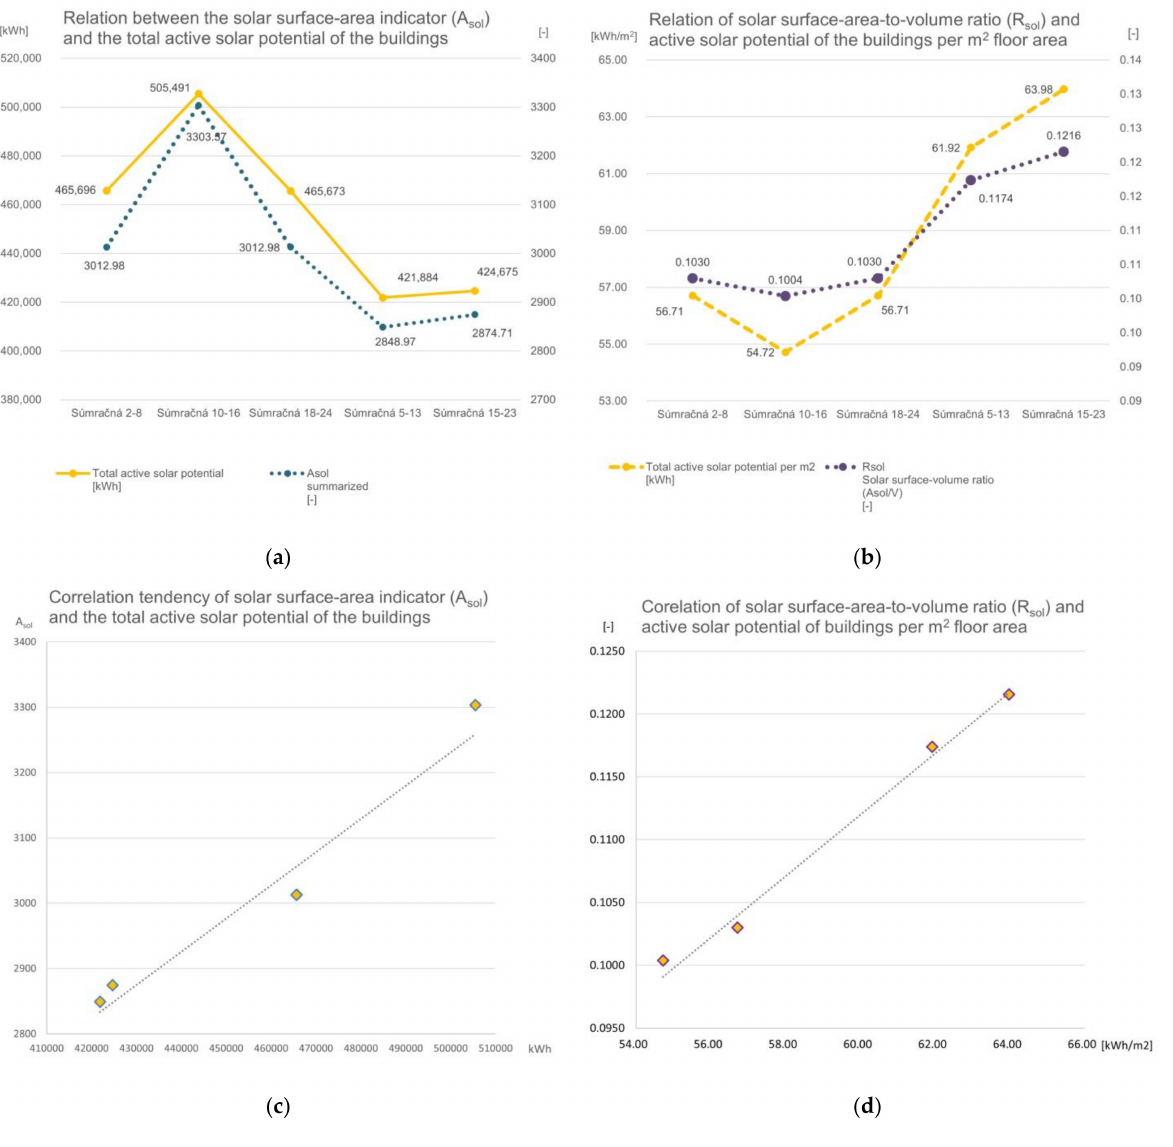
Figure 14. Four graphs visualising the calculation results shown in Table 6 and focusing on the relation between particular energy performance values and proposed indicators: ( a ) Confirmed correlation between the solar surface area indicator (A sol ) and the total active solar potential of the buildings; ( b ) The chart confirms that solar-surface-area-to-volume ratio (R sol ) and the active solar potential of the particular buildings per m 2 floor area correlate; ( c ) Correlation of solar surface area indicator (A sol ) and the total active solar potential of the buildings plotted on x-axis and y-axis; ( d ) Correlation of solar-surface-area-to-volume ratio (R sol ) and active solar potential of buildings per square meter of floor area. The correlation confirms the applicability of these indicators as tools for quick assessment of the solar performance of buildings under given